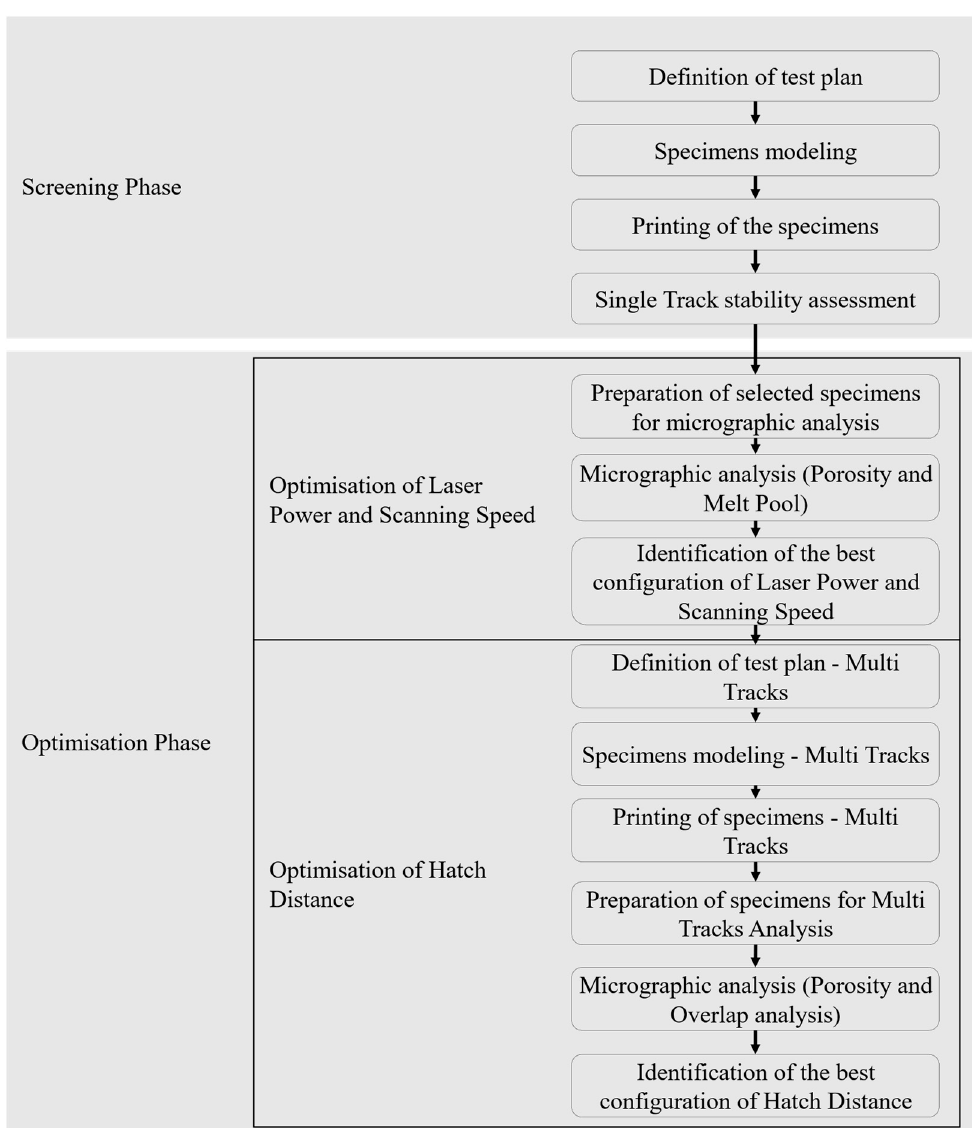
Figure 2. Flowchart of the method.